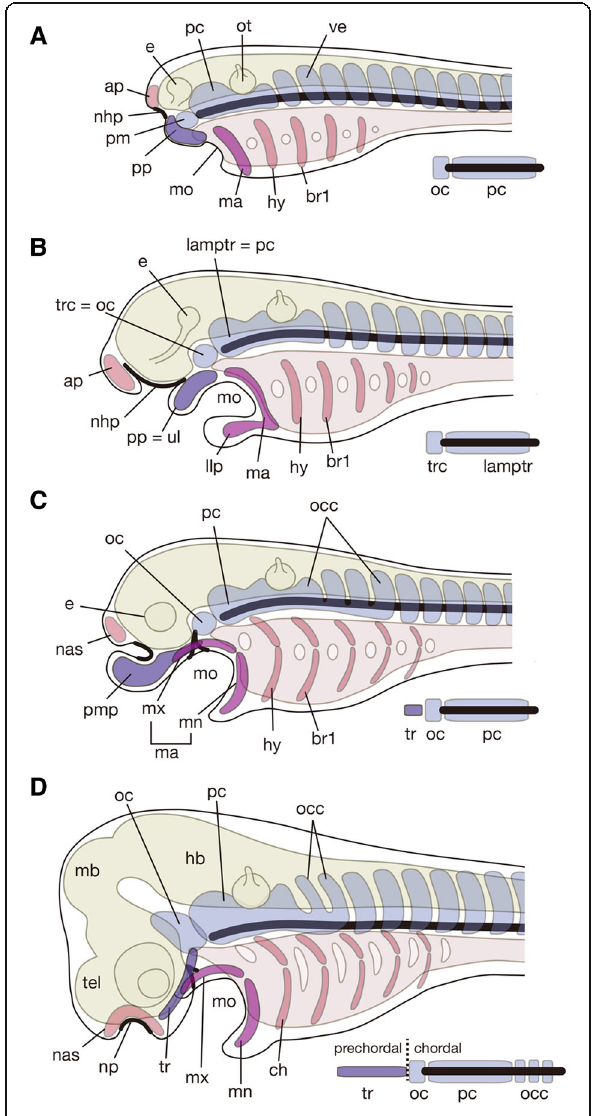
Fig. 6 Evolution of the vertebrate neurocranium to explain the establishment of composite neurocranium, as a series of evolutionary grades from a simple primitive ancestor ( a ) to modern gnathostomes ( d ). Cephalic neural crest-derived skeletal elements are colored pink except for the mandibular arch- and posterior process ectomesenchyme colored darker pink and purple, respectively. Paraxial mesodermal elements are colored light blue. For every evolutionary stage, diagrammatic composition of the neurocranium is presented on the lower right. a Hypothetical ancestral condition. The forebrain is only weakly developed, and the paraxial mesoderm is coextensive with the notochord that extends almost to the rostral tip of the body axis. Around the neural tube, the neural crest-derived ectomesenchyme is only seen around the nasal-hypophyseal placodes (nhp) as anterior and posterior processes (ap, pp). The neurocranium of this animal (only the part that covers the brain, excluding the nasal capsule) is formed only of the mesodermal tissue, consisting of the premandibular mesoderm-derived element and the parachordal. The neural crest is mostly forming oro-visceral skeleton. The rostral ectomesenchyme in the premandibular domain (pp) may have been utilized to form a part of the oral apparatus. b Idealized monorhinous jawless state, corresponding to modern cyclostomes and possibly stem gnathostomes as well. The premandibular ectomesenchyme is utilized as a part of the oral apparatus, like the upper lip of the lamprey larva (ul). c Early jawed stage as seen in a basal placoderm like Romundina [21]. The mandibular arch is dorsoventrally divided to differentiate into the upper jaw (mx) and the lower jaw (mn). d Idealised embryonic scheme of crown gnathostomes based on the elasmobranch morphology. The premandibular ectomesenchyme (corresponding to the posterior process in the ancestor) is now forming a rostral part of the neurocranium to support the expanded forebrain, and the entire neurocranium consists of a prechordal region derived from the neural crest (trabecula) and a chordal region derived from the mesoderm (orbital cartilage and parachordals). The importance of the prechordal cranium increases with the expansion of the forebrain. Note, in ( c ) and ( d ), that the posterior part of the chordal cranium has incorporated an occipital component, derived from a few rostral somites. ap, anterior process; br1, branchial arch 1; e, eye; hb, hindbrain; hy, hyoid arch; lamptr, lamprey trabecula; llp, lower lip; ma, mandibular arch; mb, midbrain; mn, mandibular process; mo, mouth; mx, maxillary process; nas, nasal capsule; nhp, nasohypophyseal plate; oc, orbital cartilage; occ, occipital cartilage; ot, otic vesicle; pc, parachordal cartilage; pm, premandibular mesoderm; pmp, premedian plate; pp., posterior process; tel., telencephaon; tr, trabecula; trc, transverse commissure in the lamprey (hypophyseal commissure in the hagfish); ul, upper